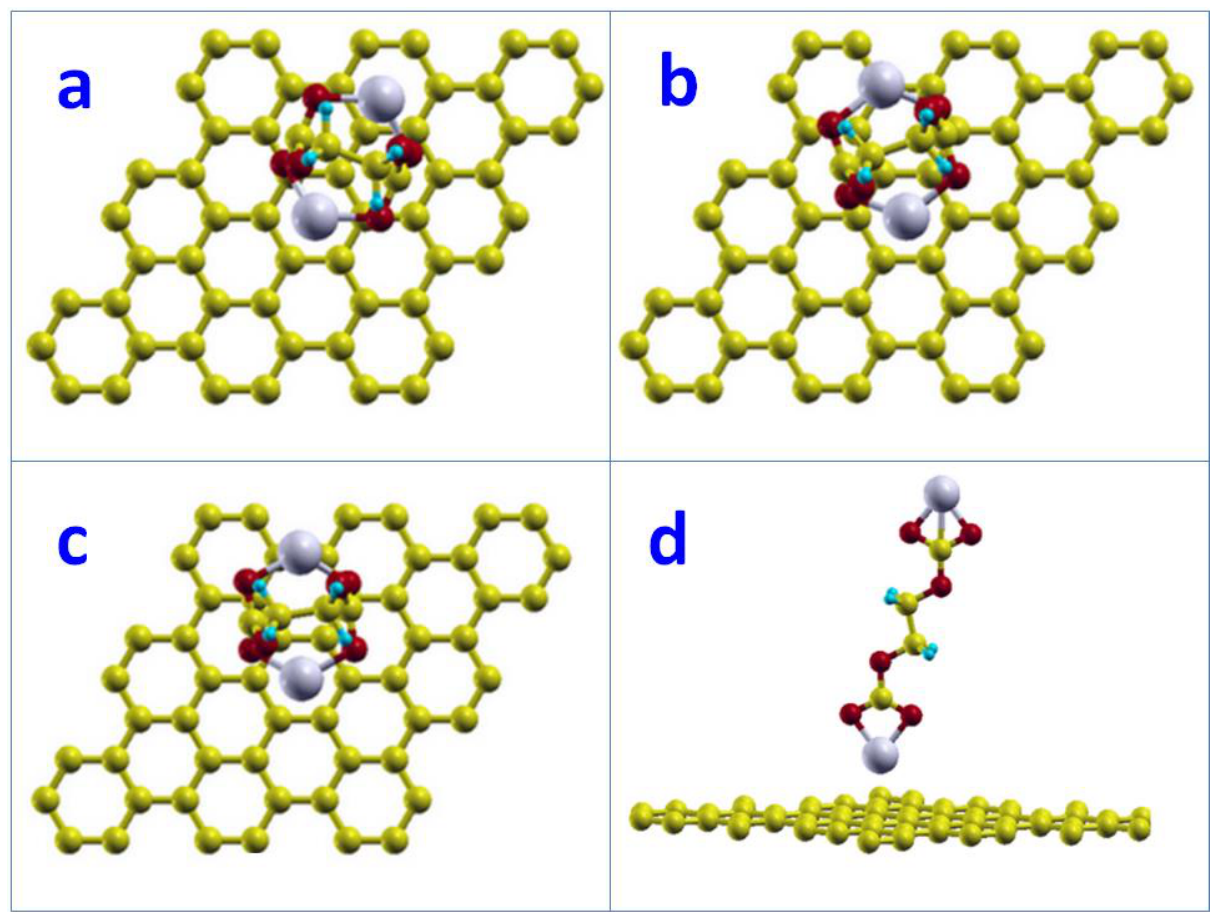
Figure 3. Adsorption of (CH 2 OCO 2 Li) 2 on graphite basal plane surface: ( a ) gauche where two lithium atoms are on Hollow-Hollow sites. ( b ) gauche where two lithium atoms are on Hollow-Top sites. ( c ) gauche where two lithium atoms are on Hollow-Bridge sites. ( d ) trans configuration.